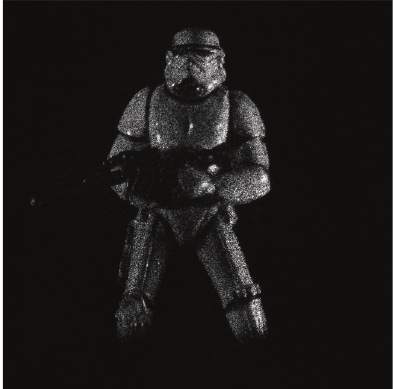
Figure 5: This reconstruction is the same as Figure 2, however both the conjugate image term and the DC terms have been removed using numerical processes described in the